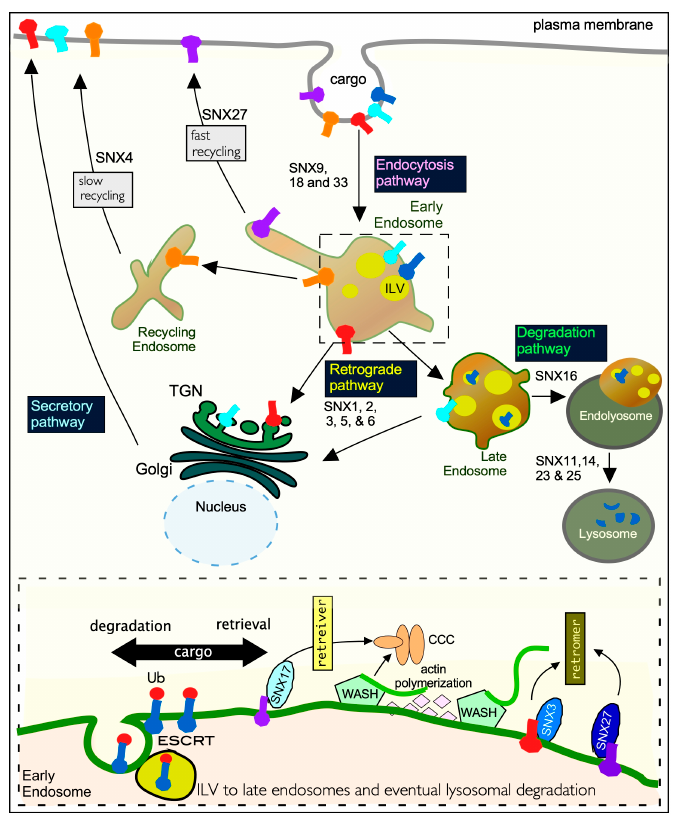
Figure 3. The role of SNXs in mammalian endocytosis. Transmembrane proteins are internalized into early endosomes from the plasma membrane by the endocytosis pathway. From here they are sorted through the complex and dynamic endomembrane network that consists of three different endosome vesicles (early, late, and recycling). Retrograde transport of membrane proteins requires recycling endosomes and the trans -Golgi network (TGN) for delivery back to the plasma membrane by the secretory pathway. Degradation of membrane proteins requires multiple rounds of cargo sorting and intra-luminal vesicle (ILV) biogenesis and fusion of the late endosome with the lysosome to form endo-lysosomes. Here ILVs and their accompanying cargos are degraded. The traced box at the bottom of the diagram is a zoomed-in schematic of sorting at endosomal membranes. It indicates that ubiquitinated membrane proteins destined for lysosomal proteolysis mediated by the ESCRT pathway. Transmembrane proteins are sorted by retromer and retrieval complexes aided by the actin remodeling WASH complex. Only SNX17 associates with the retriever and cooperates with the CCC complex to mediate endosomal trafficking. The retromer complex controls the recycling of a wide range of different cargos in cooperation with multiple SNX proteins including SNX3 and SNX27. Ub— Ubiquitin; CCC—CCDC22, CCDC93, and COMMD; WASH—Wiskott–Aldrich syndrome protein and SCAR homolog; ESCRT—endosomal sorting complexes required for